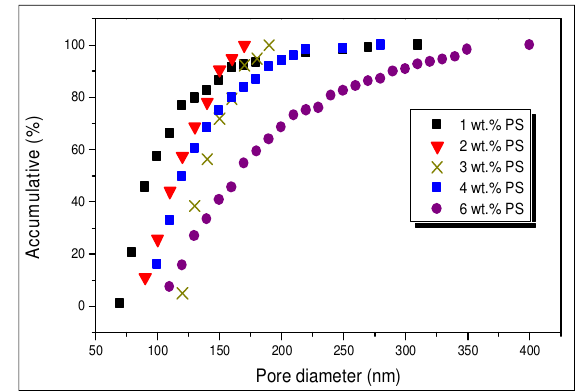
Fig. 8. Accumulative (%) of the pore diameter at the outer surface of the hollow fiber blend membranes.